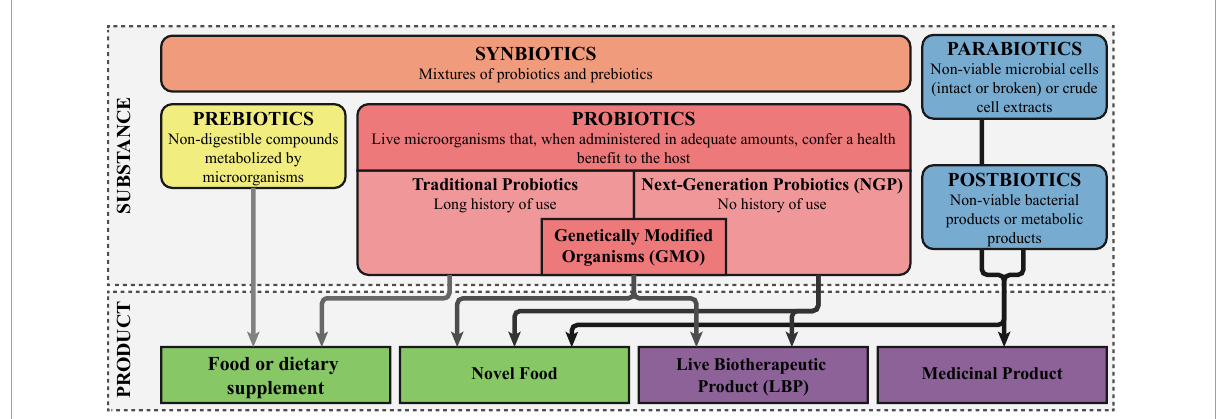
FIGURE1 Definitions of probiotics, next-generation probiotics, and live biotherapeutic products. The different “biotics” are colored orange, here denoted as the active substance. The final products are colored green, with the darker green corresponding with products that are considered drugs, while the lighter green falls within the food and food supplements